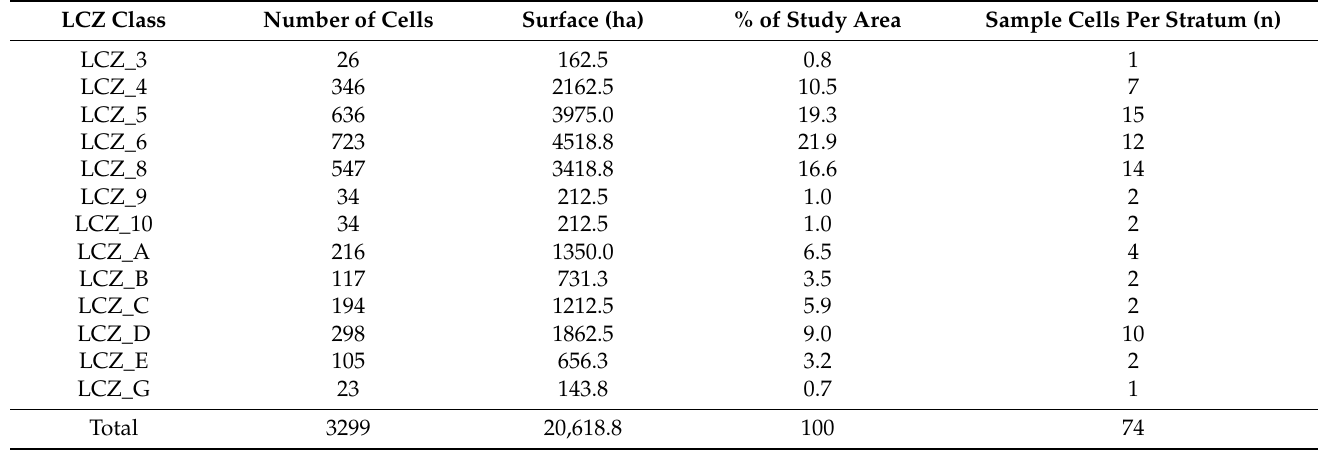
Table 1. Local climate zones